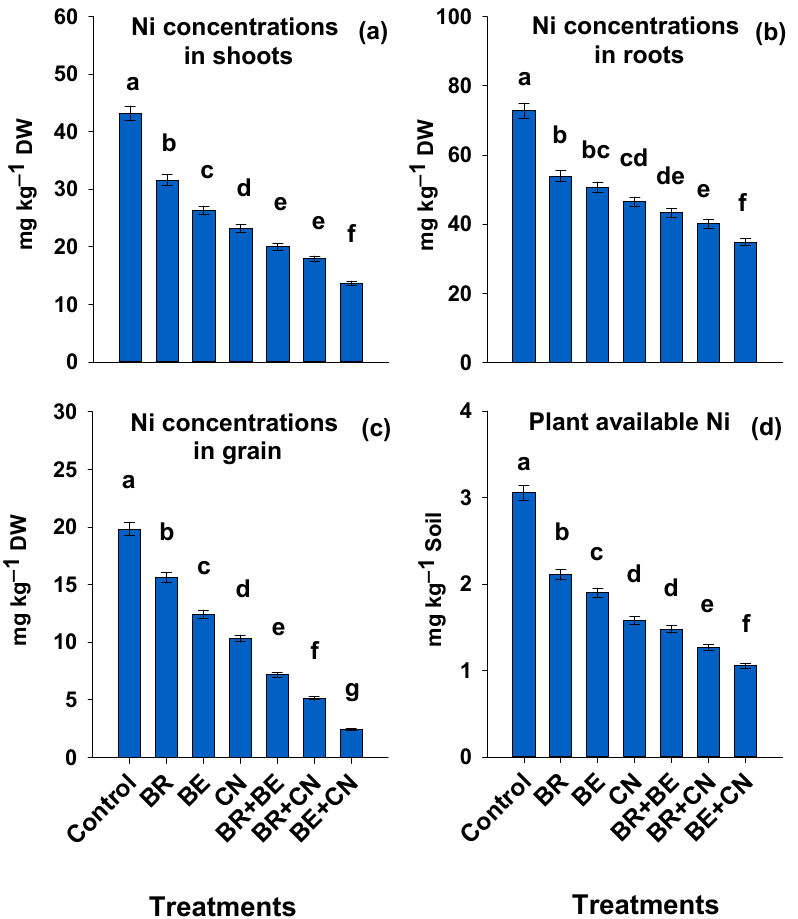
Figure 1. Nickel concentrations in lentil shoots ( a ), roots ( b ), grain ( c ), and DTPA-extractable fraction ( d ) as influenced by adding BR, BE, and CN in a Ni-affected soil. Values characterized by the same letter are not significantly different at the α = 0.05 level. These values are the mean of three replicates ± SE.